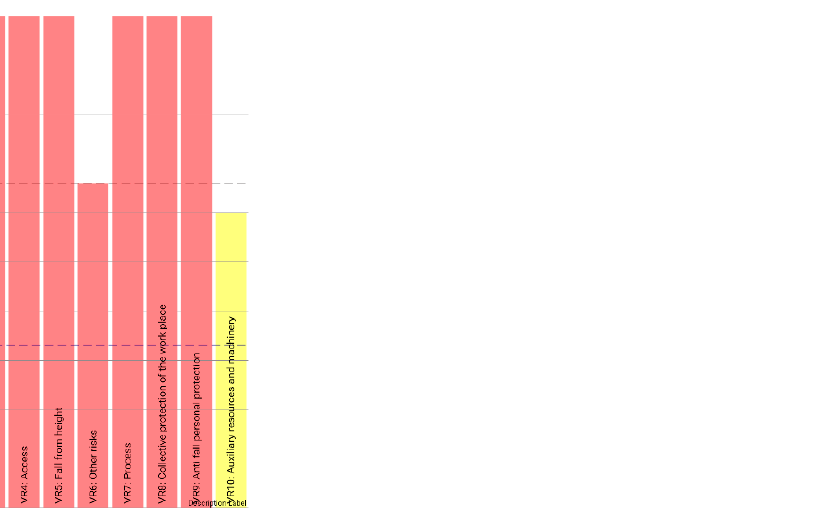
Figure A5. Relationship among risk levels and organizational and resources variables.